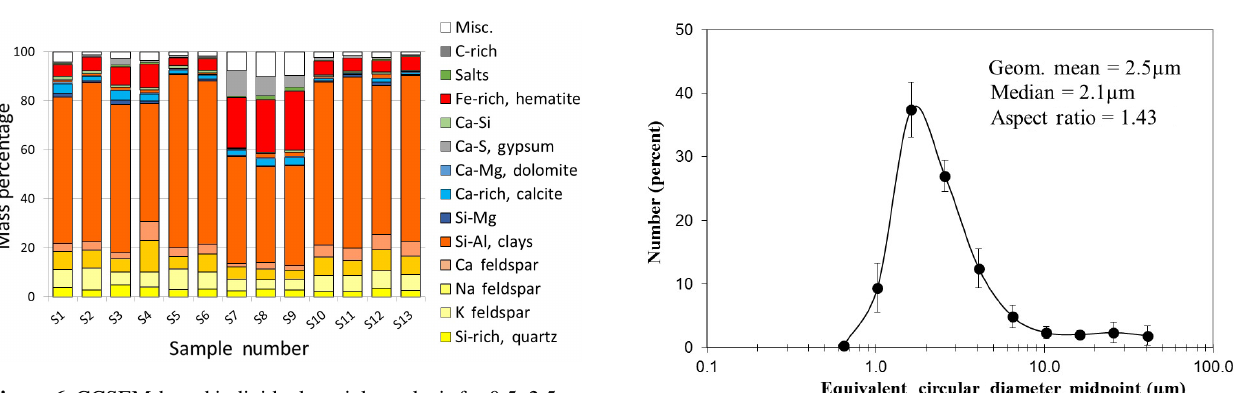
Figure 6. CCSEM-based individual particle analysis for 0.5–2.5µm (fine) subset, with the chemical bins labeled as minerals, arranged by normalized mass percentage.